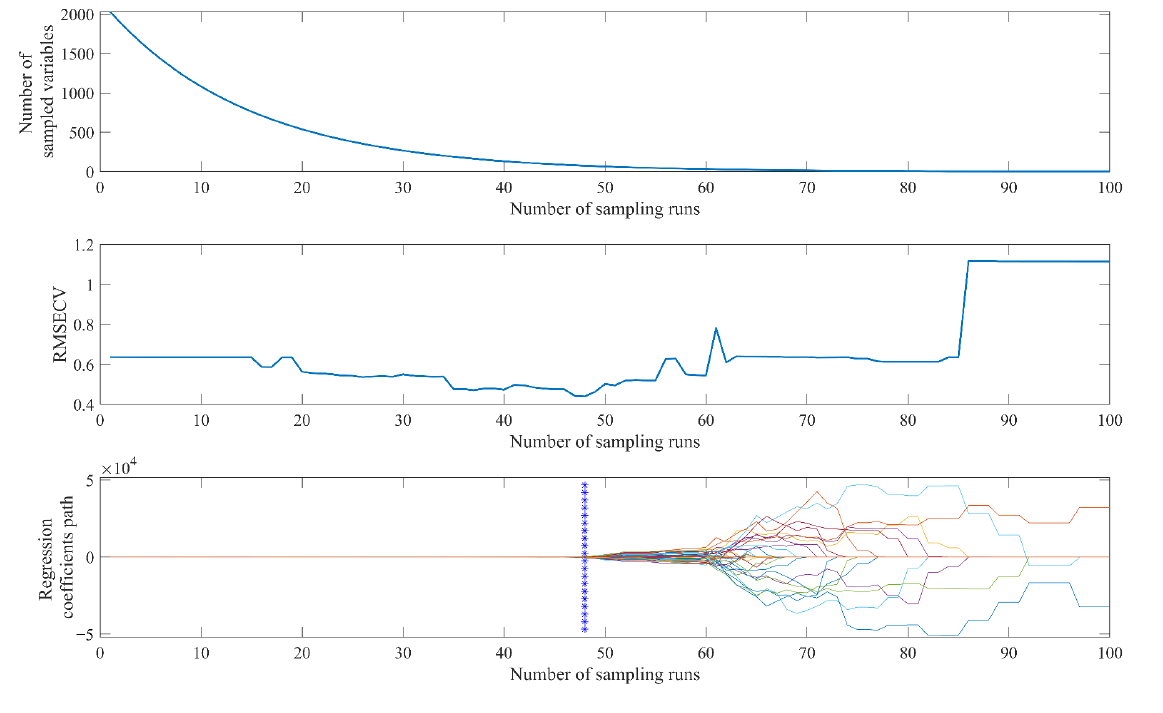
Figure 4. CARS variable selection on geniposide dataset. Table 4. Comparison of results based on different variable selection methods.